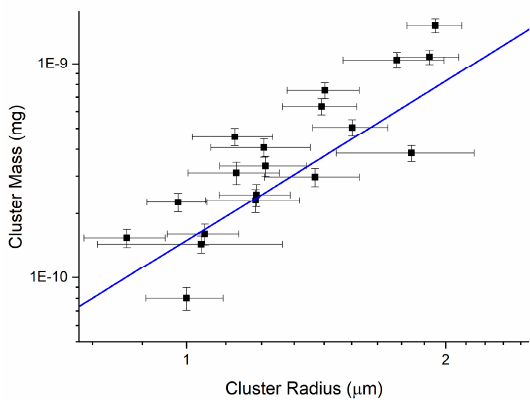
Figure 6 . Calculated cluster mass plotted as a function of measured cluster radius. Log–log plot of Equation (1) fit to experimental data. The data collected were cluster mass and cluster size. The straight line fit on a log–log plot indicates a mass scaling dimension of 2.5 ± 0.4.